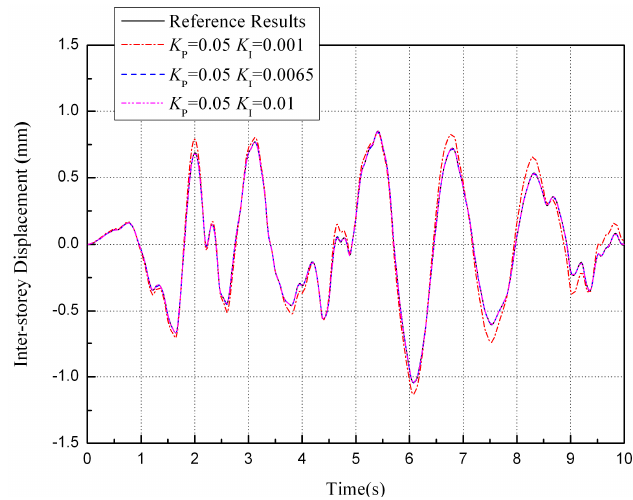
Figure 14. Time history curves of story drift with different integral gains.